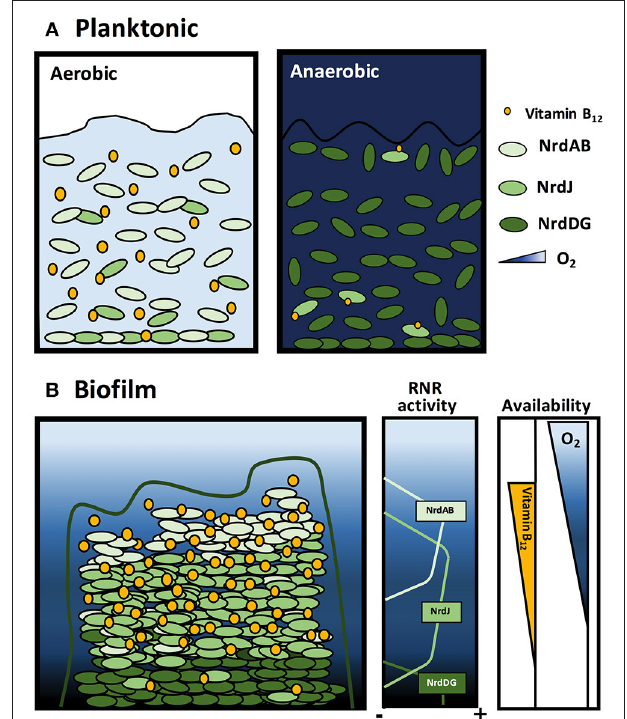
FIGURE 7 | Model of ribonucleotide reductase activity and vitamin B 12 availability during P. aeruginosa planktonic and biofilm growth. Scheme of P. aeruginosa growing in (A) aerobic and anaerobic planktonic cultures and (B) biofilm. Orange circles represent the vitamin B 12 gradient, blue indicates oxygen concentration gradients and green indicates class Ia, II and III RNR